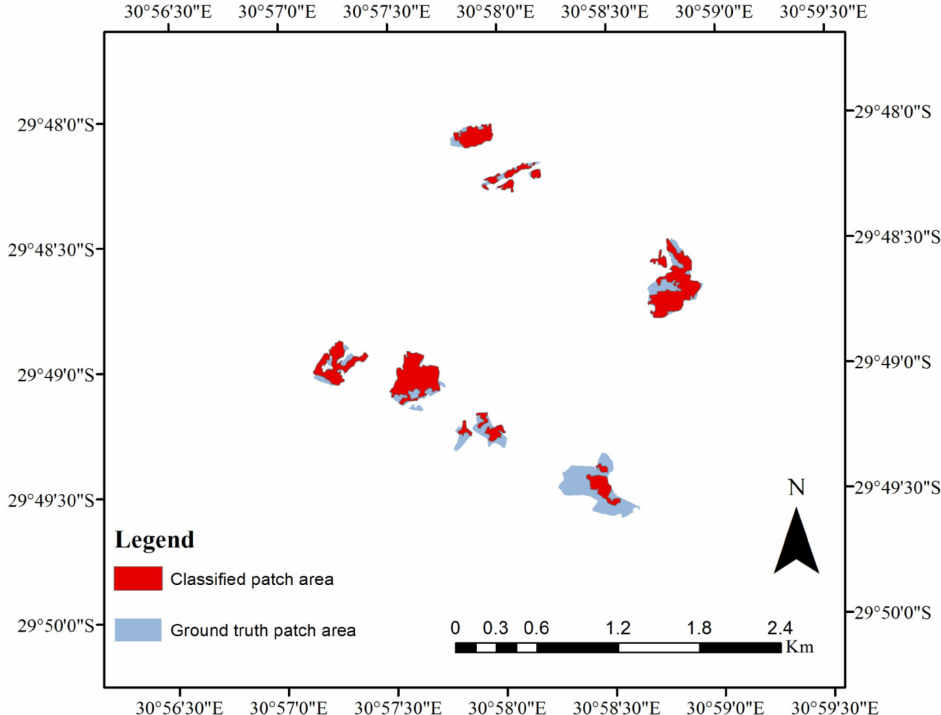
Figure 4. Classified informal settlement patch areas against ground truth patch